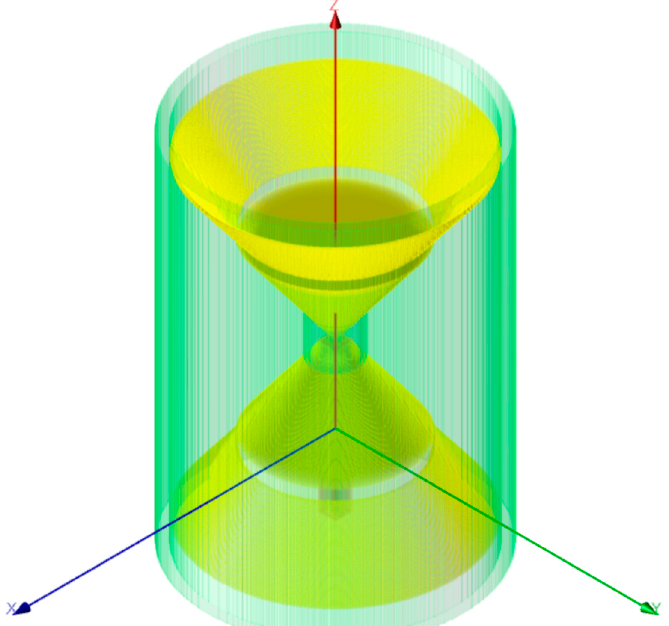
Figure 6. The base MBA is modeled in General-Purpose EM solver (GEMS); the green parts are dielectric material, and the yellow parts are modified metal cones and TEM-line.